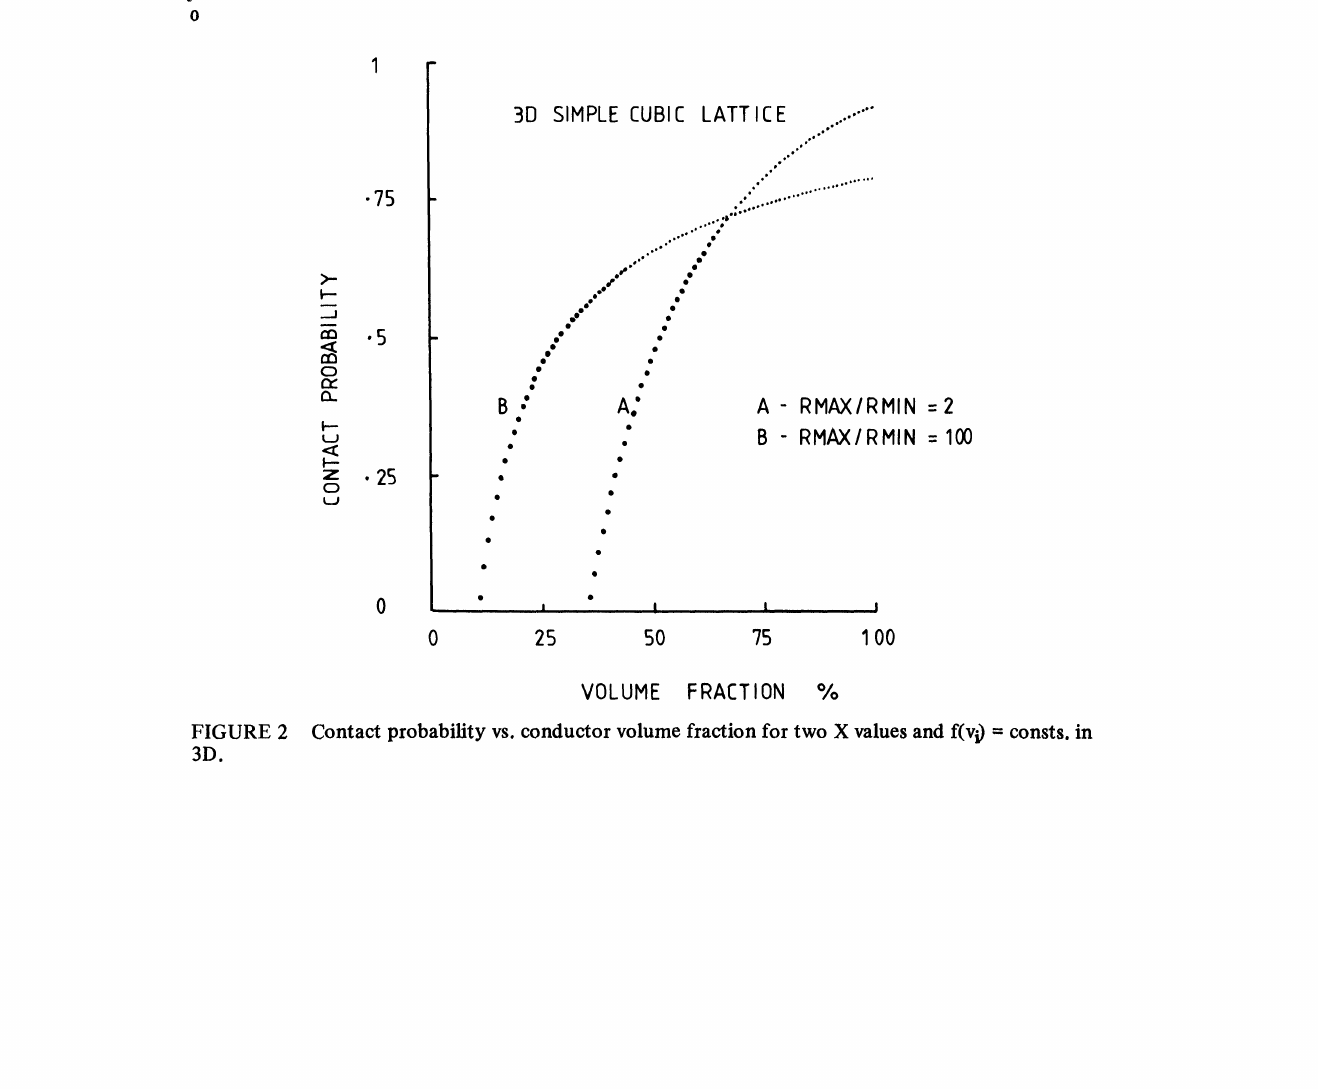
VOLUME FRACTION % FIGURE 2 Contact probability vs. conductor volume fraction for two X values and f(vi) consts, 3D.